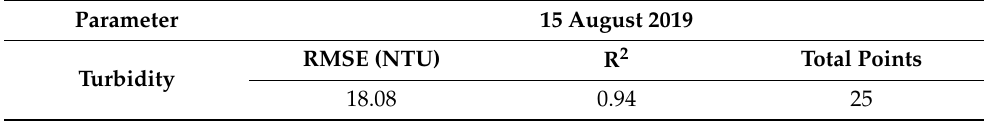
Figure 12. Scatterplot between the predicted and observed turbidity values for the 15 August 2019 image acquisition. Table 7. Accuracy assessments of turbidity estimation model’s performance for August image